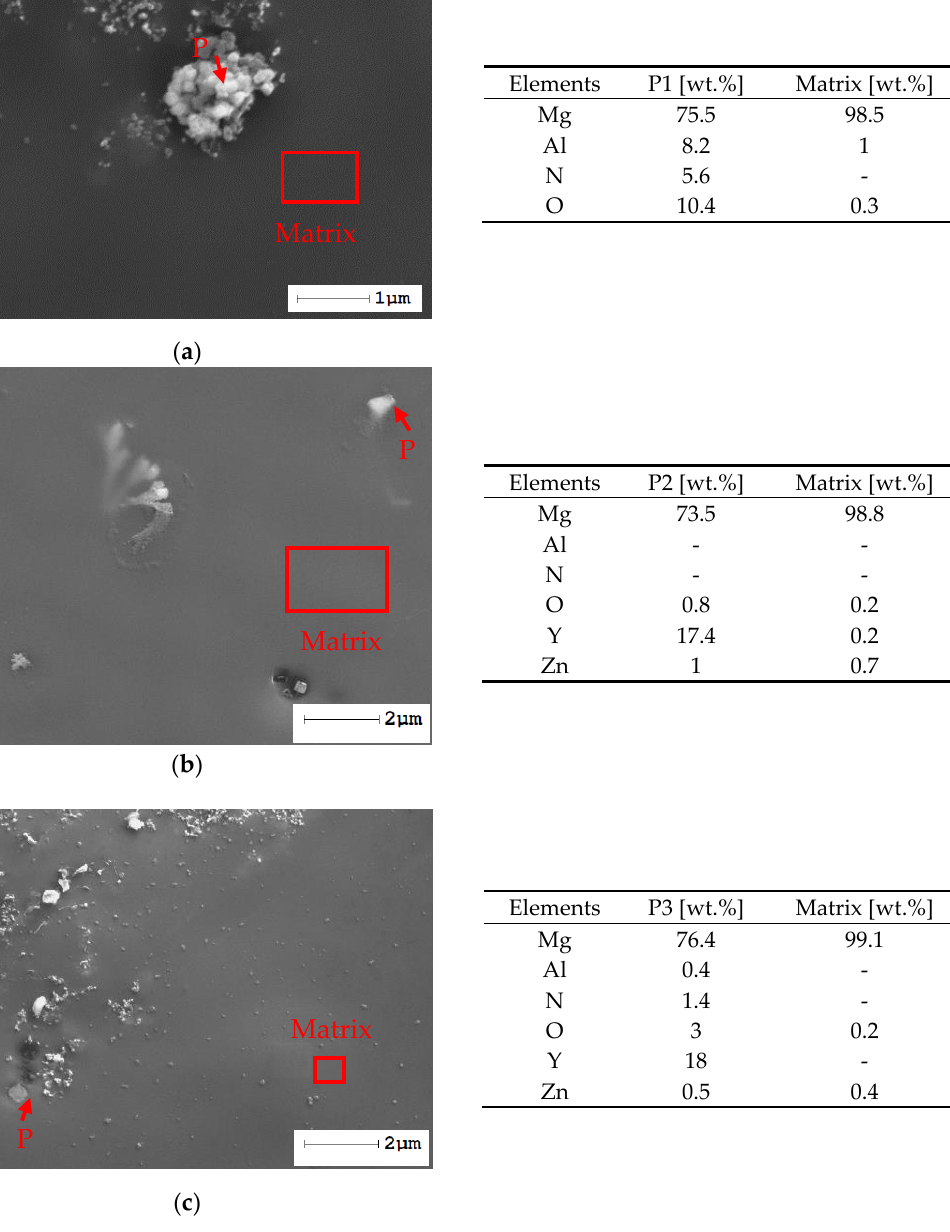
Figure 2. SEM micrographs and EDX analysis of ( a ) Mg + 1.5AlN, ( b ) ZW0303, and ( c ) ZW0303 + 1.5AlN.